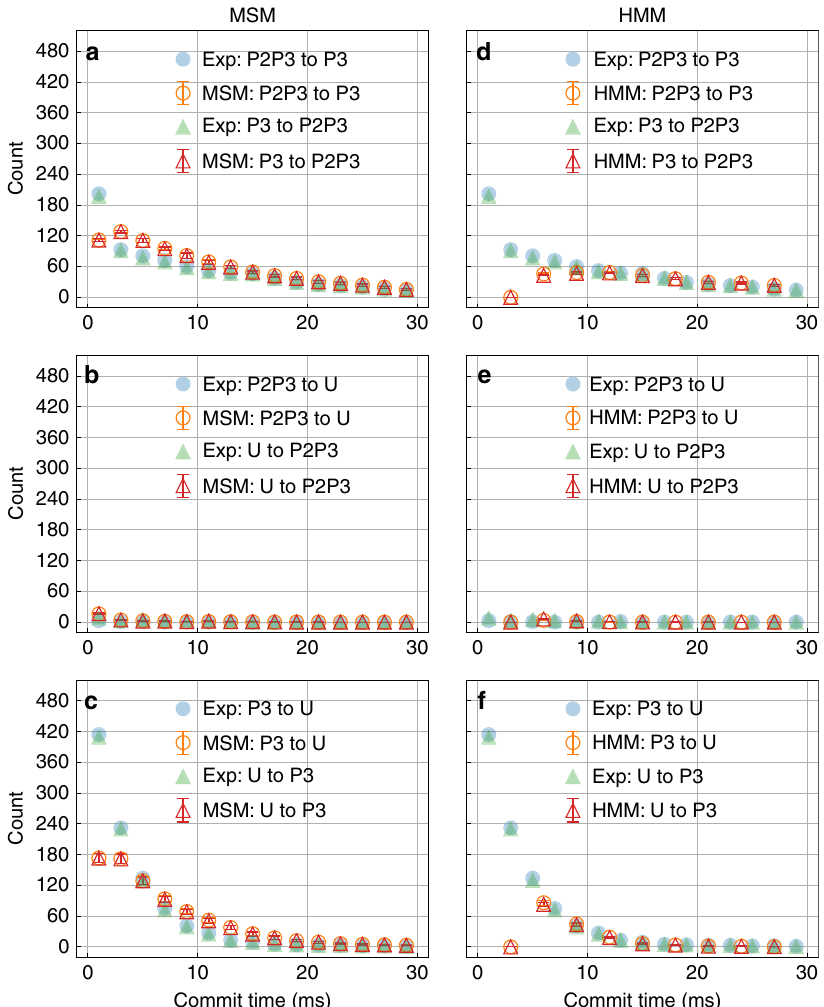
Fig. 8 Riboswitch kinetics through alternate approaches. Number of transitions between different pairs of metastable states as a function of commitment time de fi ned in “ Results ” section for the single molecule spectroscopy trajectory as learned by MSM (left column) and HMM (right column). Associated error bars calculated as standard errors are also